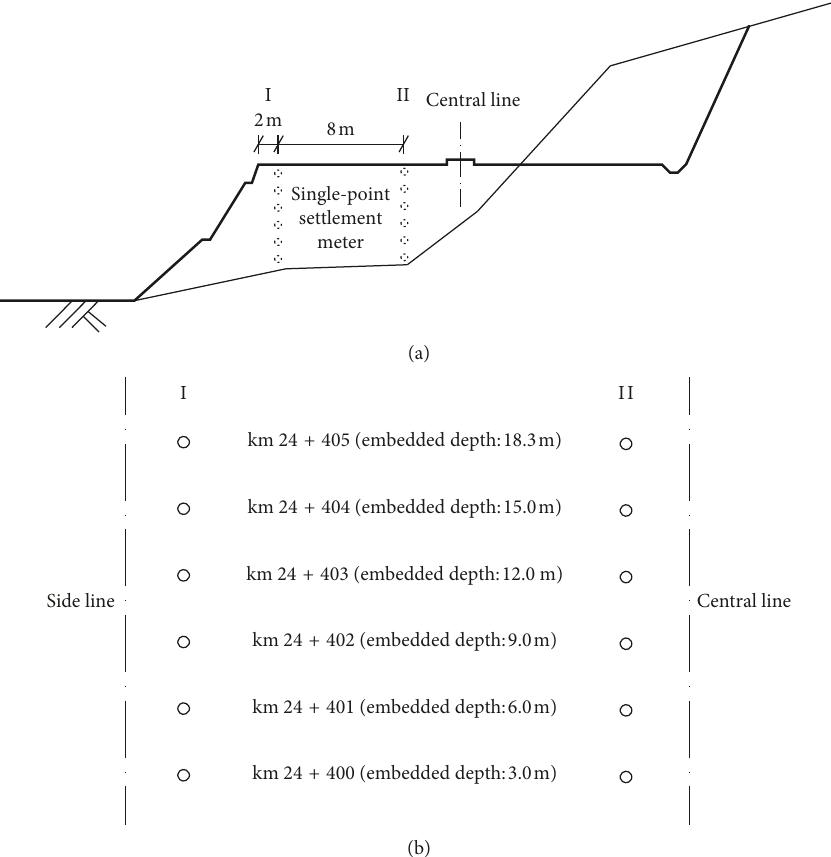
Figure 2: (a) Layout profile of the single-point settlement meters. (b) Planar graph of the single point settlement